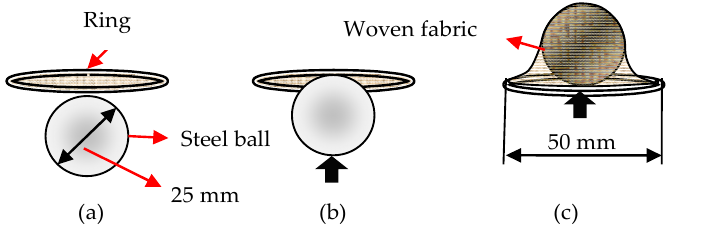
Figure 7. The process of bursting the fabric by punching with a steel ball: ( a ) placing fabric in the ring, ( b ) beginning the strain, and ( c ) strain immediately before the ball burst through the fabric.